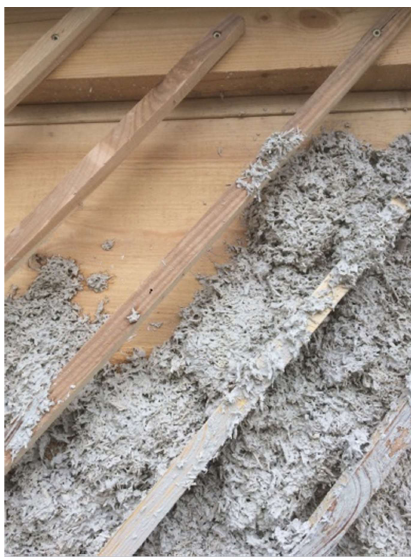
Figure 7. Applying the hemp-lime onto the wall surface.